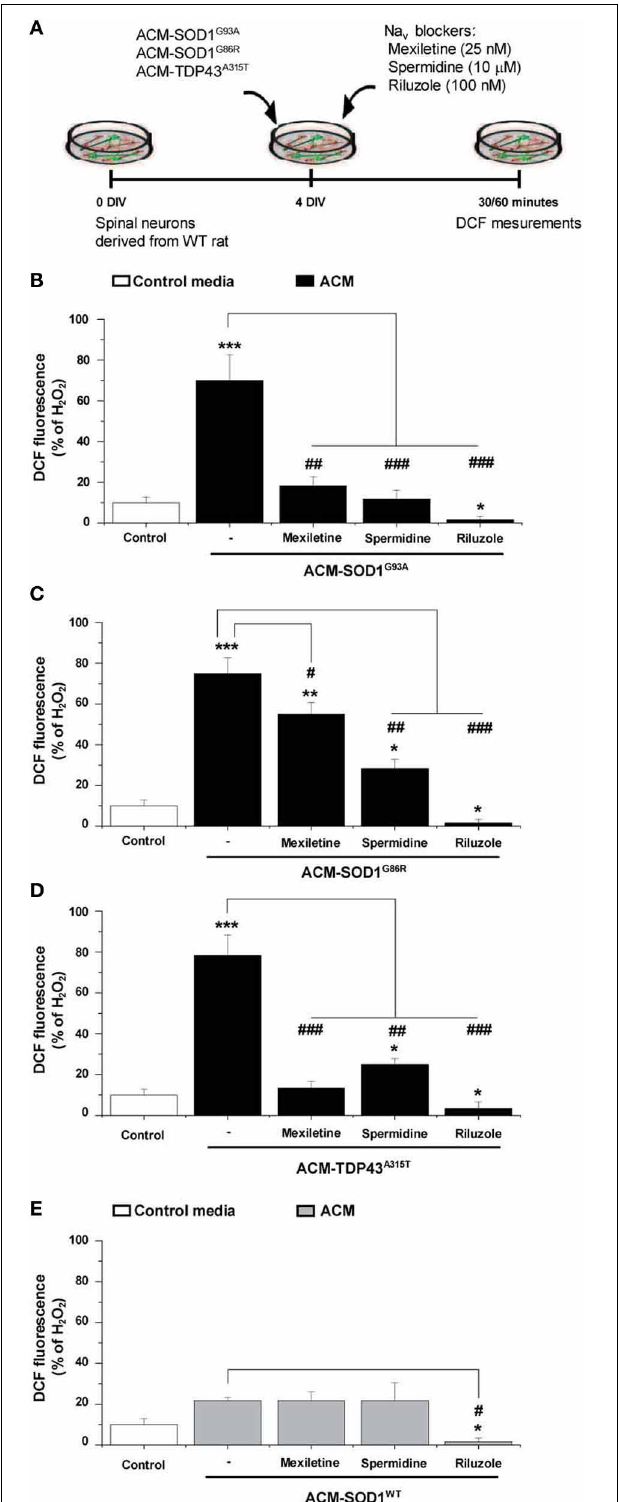
FIGURE 6 | Na v channel blockers reduce DCF fluorescence induced by ACM-SOD1 G93A , ACM-SOD1 G86R , and ACM-TDP43 A315T . (A) Flow diagram of experiment. Spinal cultures (4 DIV) were exposed for 30